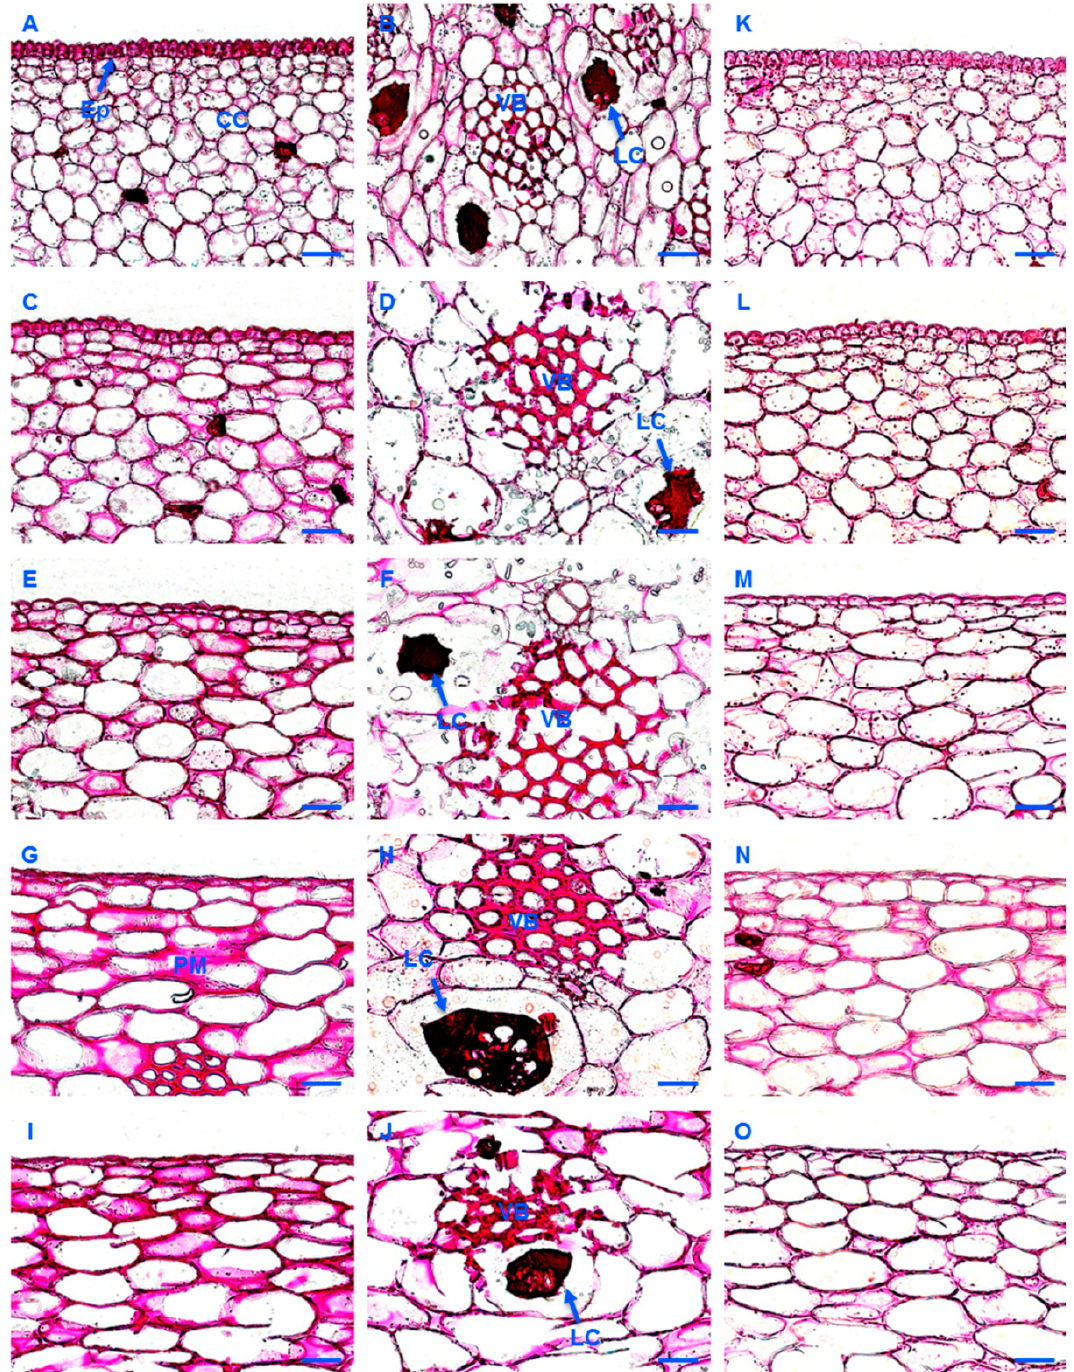
Figure 4. Histological analysis of pectin ( A – J ) and de-methyl-esterified pectin ( K – O ) in banana ( Musa spp. AAA) peel during fruit development and ripening. ( A – J ) Sections stained with ruthenium red after NaOH treatment; ( K – O ) Sections stained with ruthenium red; ( A , B , K ) Peel of fruits just emerging from the bunch; ( C , D , L ) Peel of 35 day-old fruits; ( E , F , M ) Peel of 60 day-old fruits; ( G , H , N ) Fruit peel at harvest; ( I , J , O ) Fruit peel 6 d after ethylene treatment. Ep, epidermis; LC, latex cells; PM, plasma membrane; VB, vascular bundle. Bar = 50 μ m.